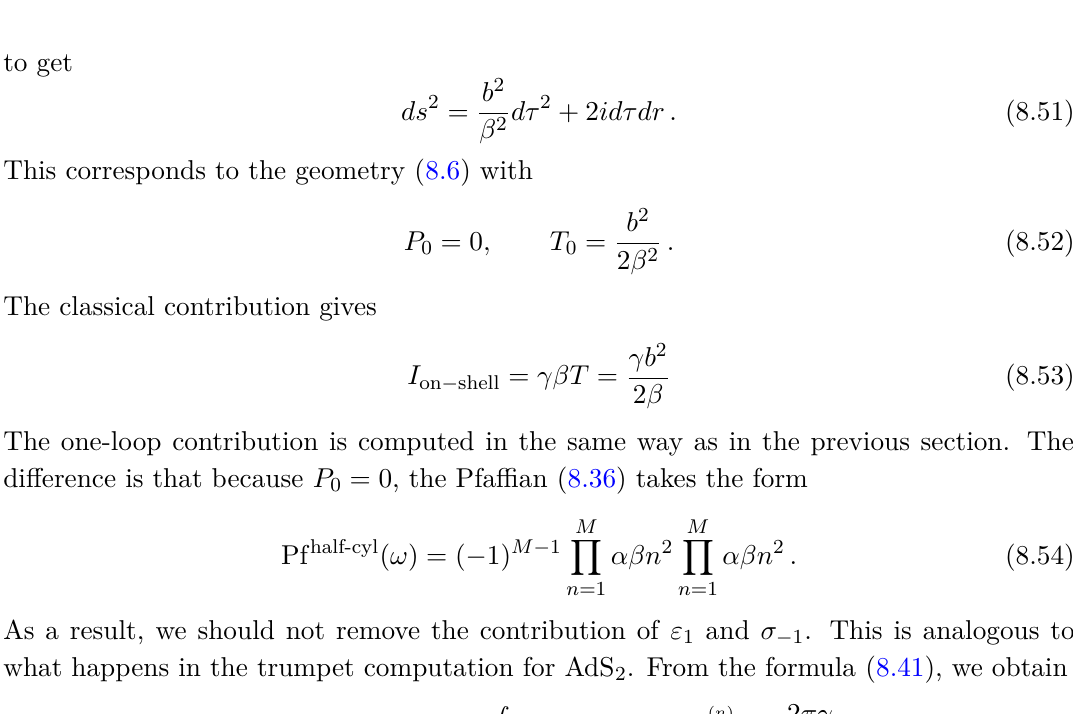
Figure 4 . The cylinder geometry. We specify two boundary conditions β 1 and β 2 at each end. The only modulus is the circumference b